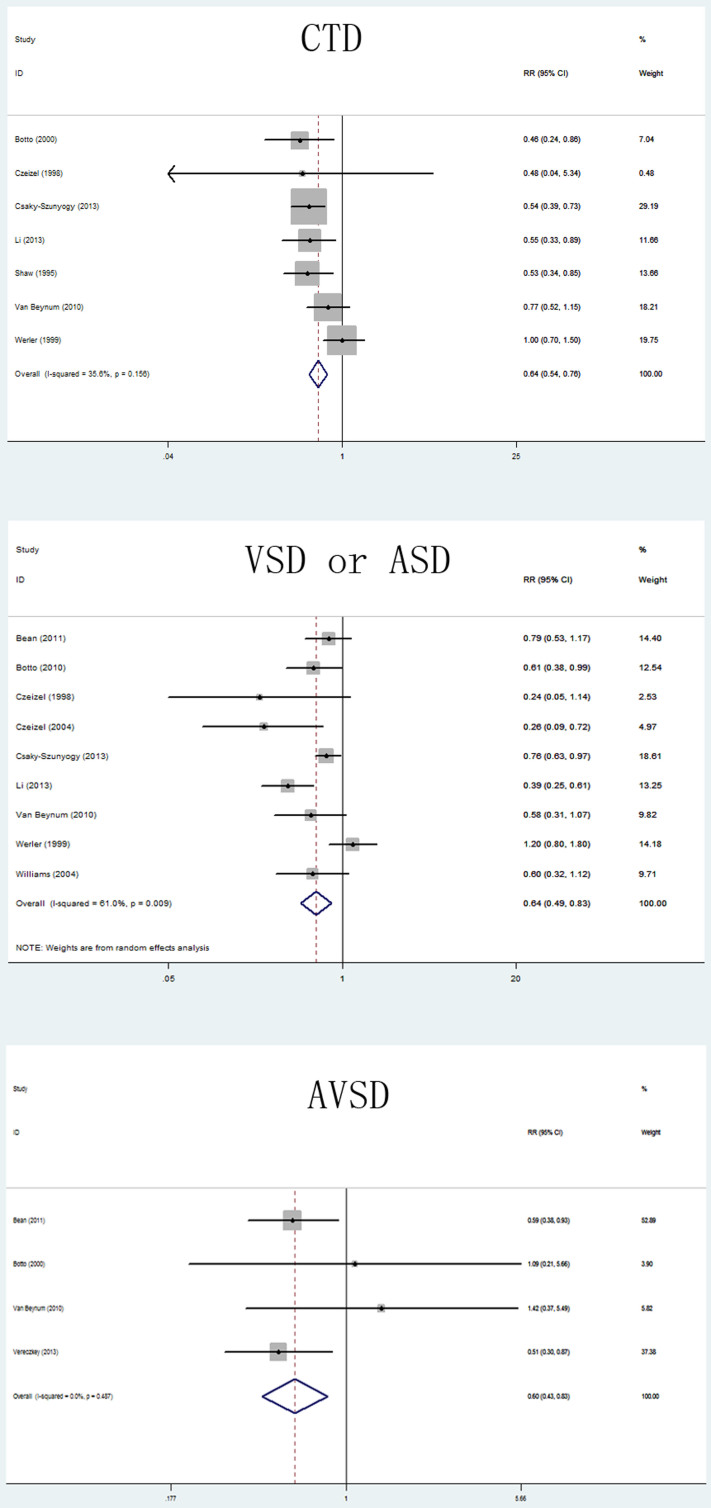
Relative risk (RR) estimates for the association between maternal folate supplementation and the risk of individual subtypes of CHDs (CTD; ASD or VSD; and AVSD).Meta-analysis random-effects estimates were used. The sizes of the squares reflect the weighting of the included studies. Bars represent 95% confidence intervals (CIs). The center of the diamond indicates the summary effect; the left and right points of the diamond indicate the 95% confidence interval.